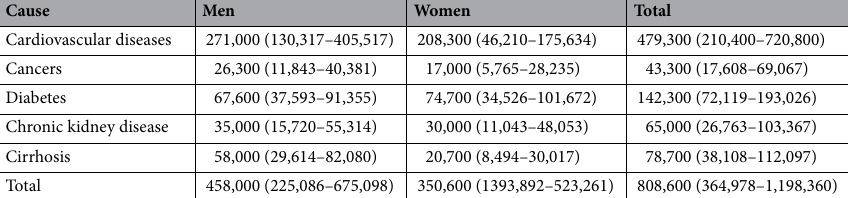
Table 3. Deaths attributable to overweight over a 10-year simulation period, from 2021 to 2030, in Brazilian adults aged 20–79 years. Brackets contain 95% uncertainty intervals.